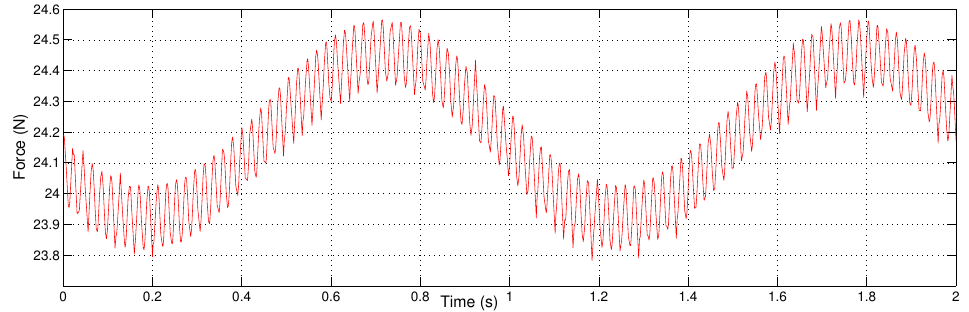
Figure 3. Block diagram of drilling simulation with induced fault.